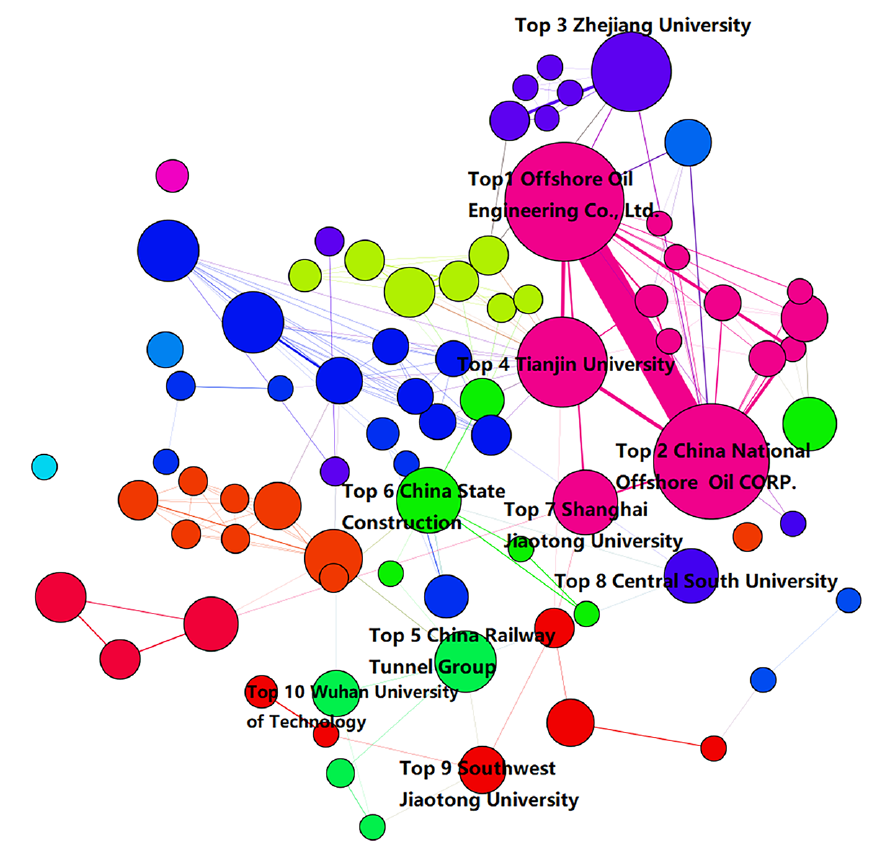
Figure 8. Enterprise-university cooperative